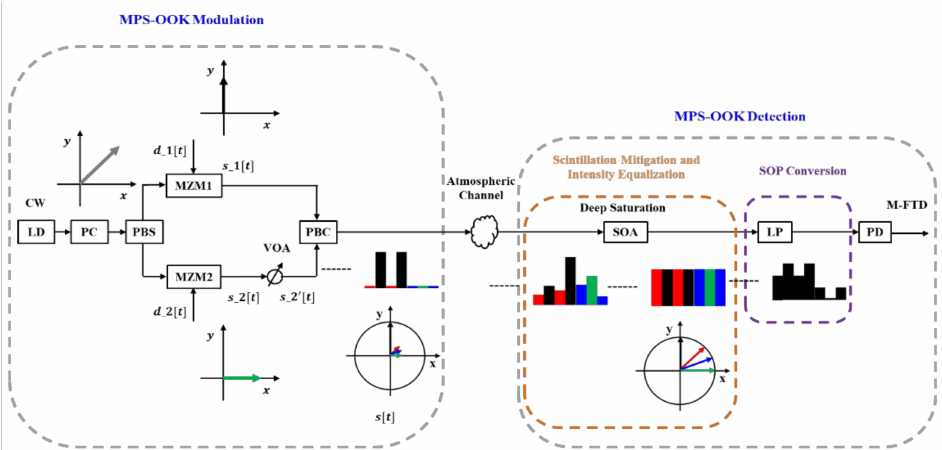
Figure 1. Block diagram of the proposed technique. CW: continuous wavelength, LD: laser diode, LP: linear polarizer, M-FTD: multilevel fixed-threshold decision, MPS-OOK: multilevel polarization shift on–off keying, MZM: Mach–Zehnder modulator, PBC: polarization beam combiner, PBS: polarization beam splitter, PC: polarization controller, PD: photodiode, SOA: semiconductor optical amplifier, SOP: state of polarization, VOA: variable optical